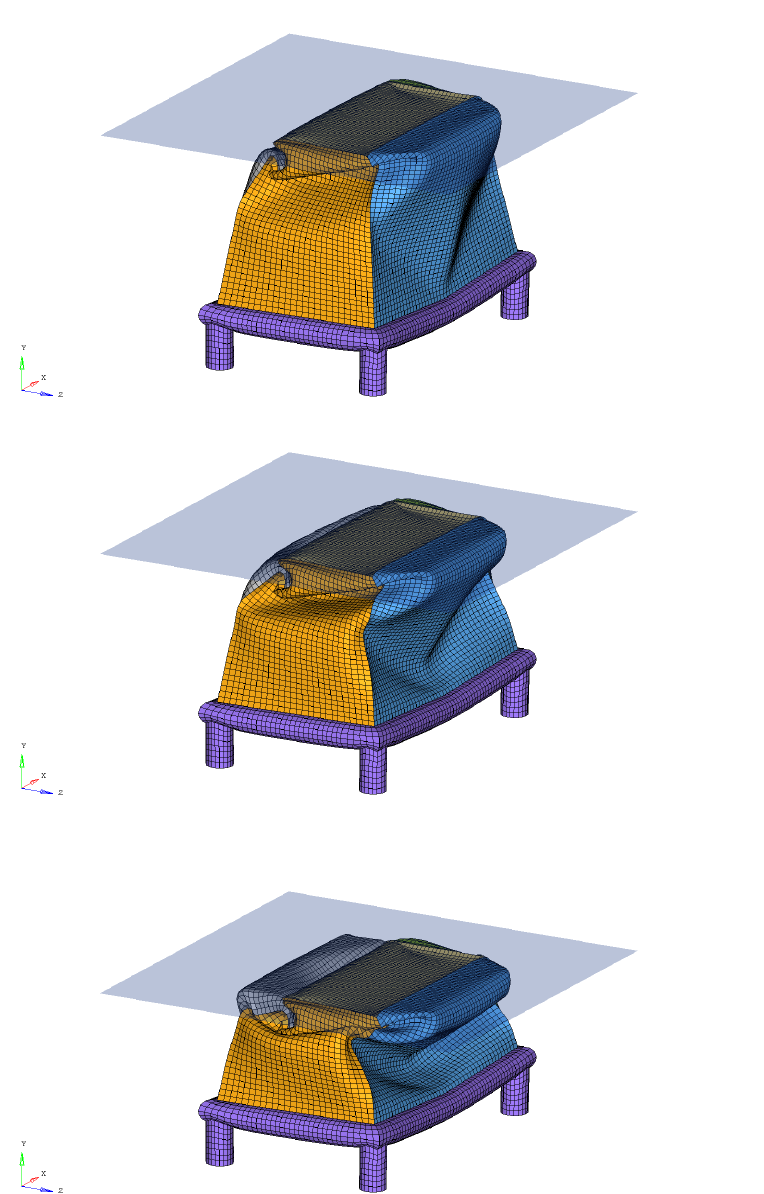
Figure 9. Images from the simulation of the test following the regulation conditions at 17, 22 and 38